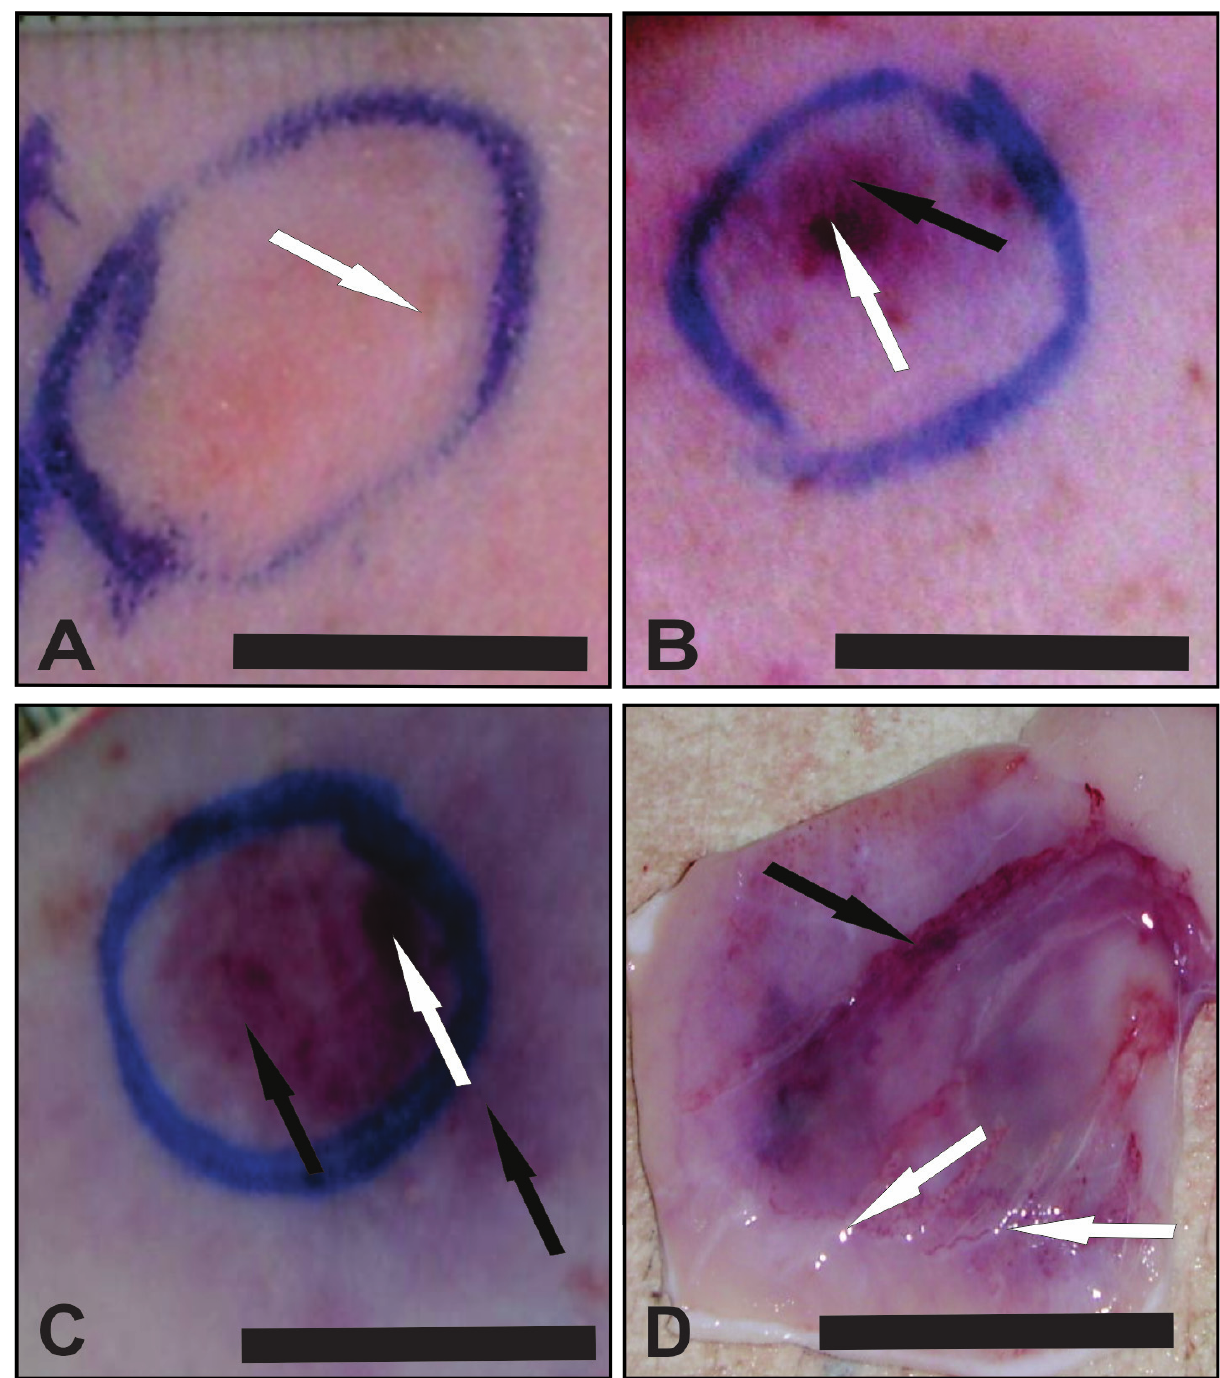
Figure 1. Macroscopic picture of rabbit skin: ( A ) control group – note the site of injection of 50 µL de PBS (white arrow); ( B ) experimental group – note the site of venom injection (white arrow) and the purple area (black arrow) two hours after injection of 50 µL (0.5 µg) of crude venom of L. similis ; ( C ) experimental group - 8 hours after the injection of 50 µL (0.5 µg) of venom, note how the lesion spreads radially (black arrows); ( D ) experimental group – 8 hours after the injection of 0.5 µg of venom, note the edema (white arrow) and hemorrhage (black arrow) on the hypodermis. Bar = 1